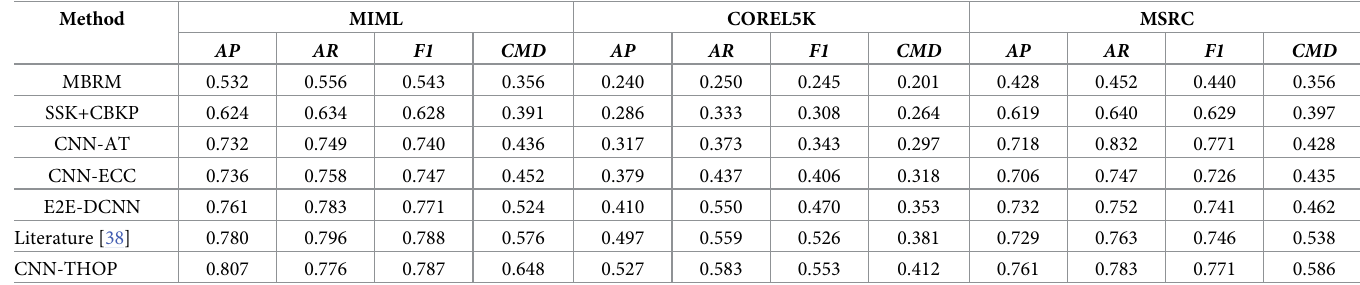
Table 5. Experimental results of various image annotation methods applied to different datasets.